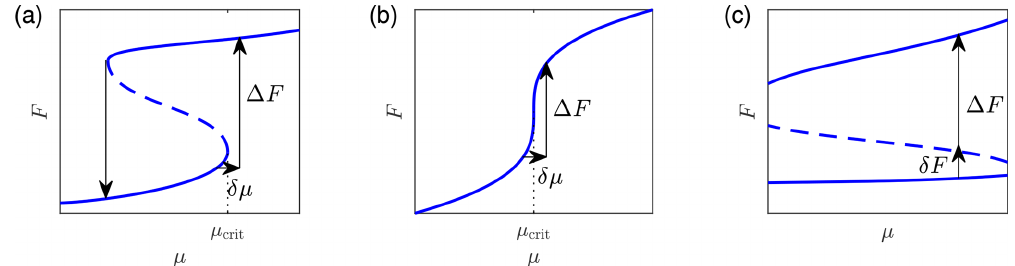
Figure 1. (a) Hysteresis arising from two saddle-node bifurcations. (b) A cusp bifurcation. (c) A bistable system. Solid curves indicate stable states, and dashed curves are unstable states. In panels (a) and (b) a small change δµ in the control parameter near the bifurcation value µ crit causes a large change (cid:49)F in the system. In panel (a) the return bifurcation happens at a different value of µ . In panel (c) a small perturbation δF in the system causes a large change (cid:49)F